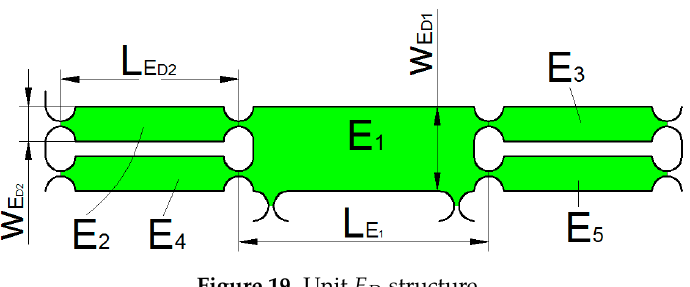
Figure 19. Unit E D structure. Figure 19. Unit 𝐸 (cid:3005) structure.